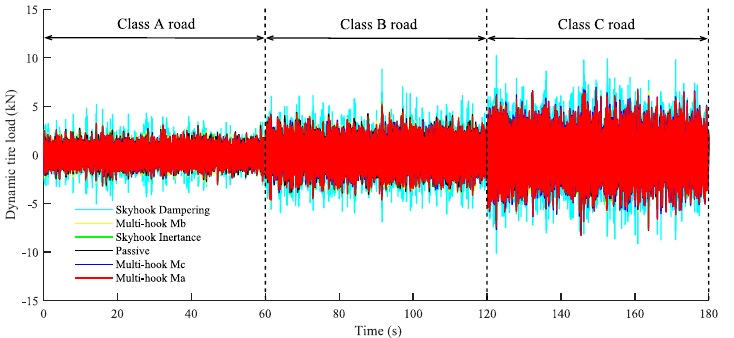
Figure 9. Time response comparison of dynamic tire load for single-skyhook and multi-hook control strategies.